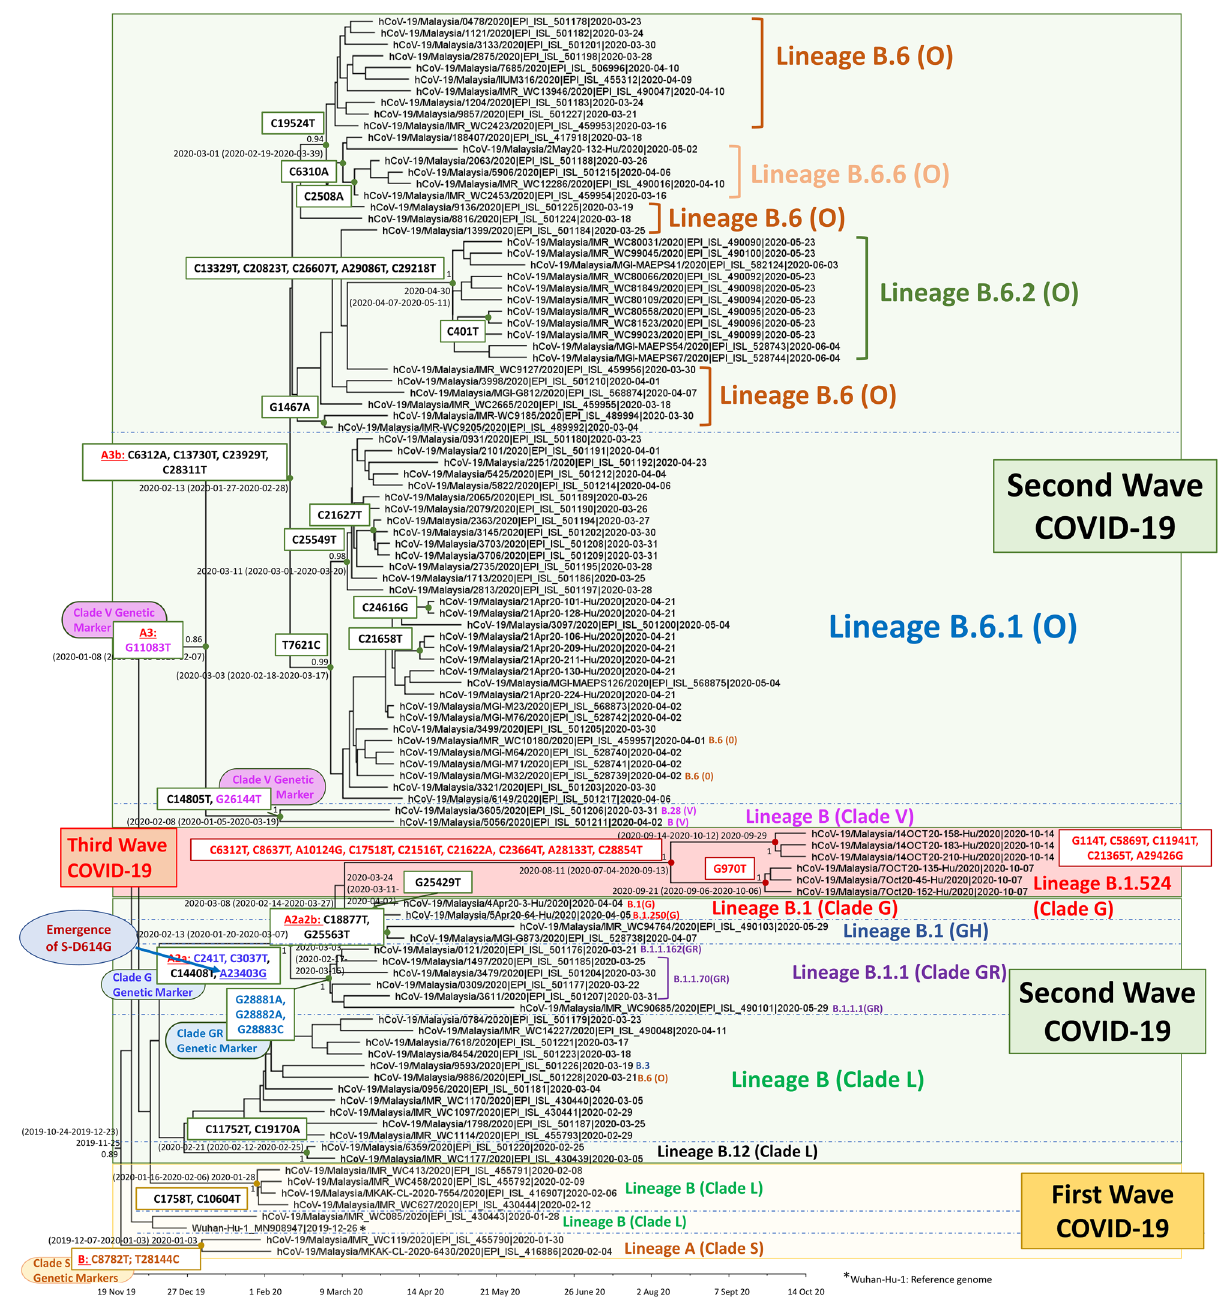
Figure 1. Maximum clade credibility (MCC) tree of SARS-CoV-2 isolated in Malaysia. The phylogenetic tree was constructed using the near-complete genome of SARS-CoV-2 strains (position 66-.29674). The major circulating lineages in Malaysia and their respective molecular signatures were